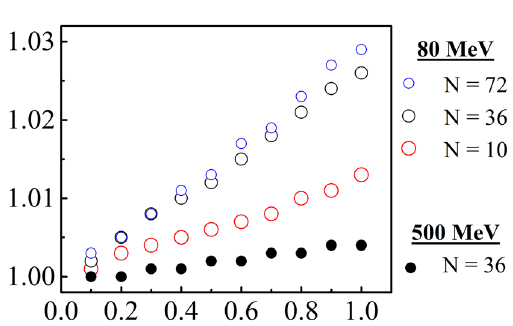
FIG. 4. The dependence of Δ ¼ 3 ½ fs (cid:2) for N ¼ 10 , 36 and 72 with 80 MeV injecting f for Δ t energy and gap spacing d ¼ 5 mm (open circles) and for N ¼ 36 with 500 MeV injecting energy and gap d ¼ 31 mm (solid